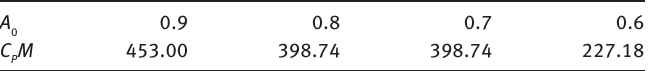
Using Hybridization FLC-GA and LS. 0